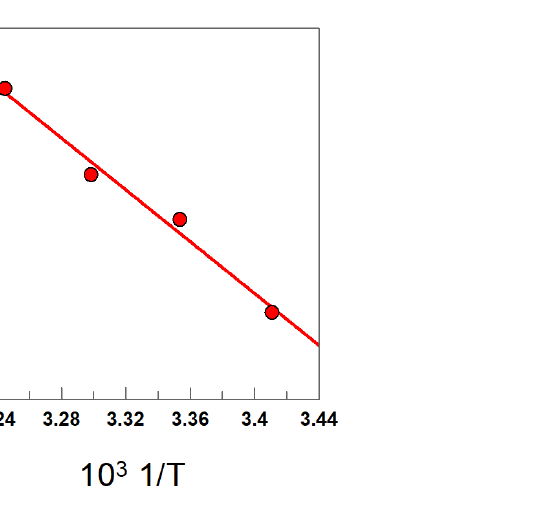
Figure 10. Variation of the partition constant P WO of propyl gallate (PG, left ) and α -tocopherol (TOC, right ) with 1/ T (K − 1 ) in binary corn oil–water mixtures according to the van’t Hoff equation. Data from [83] (PG) and [84] (TOC).